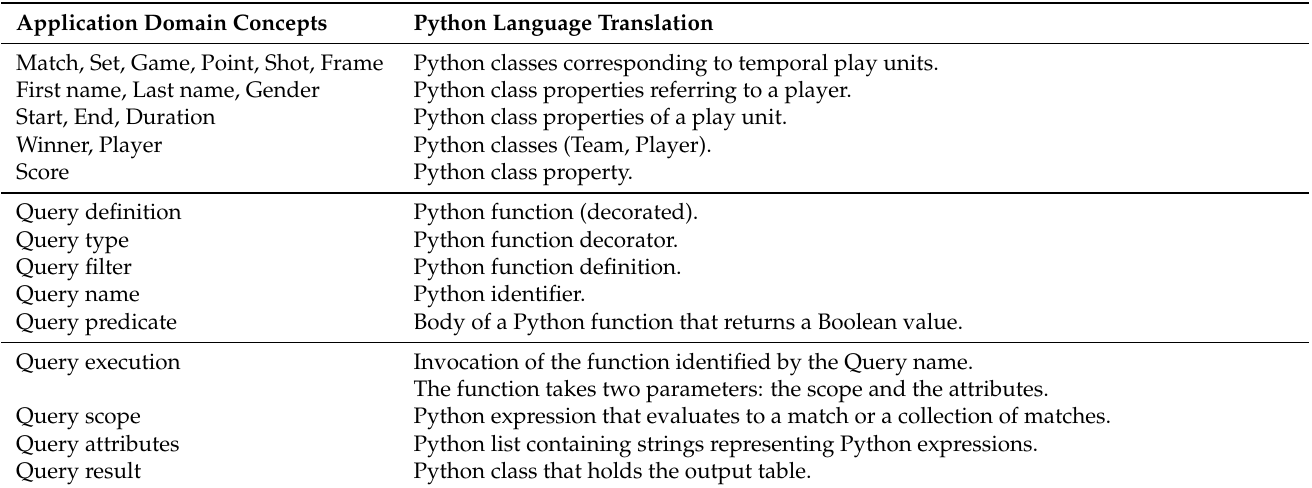
Table 4. Translation of the application domain concepts to Python language.